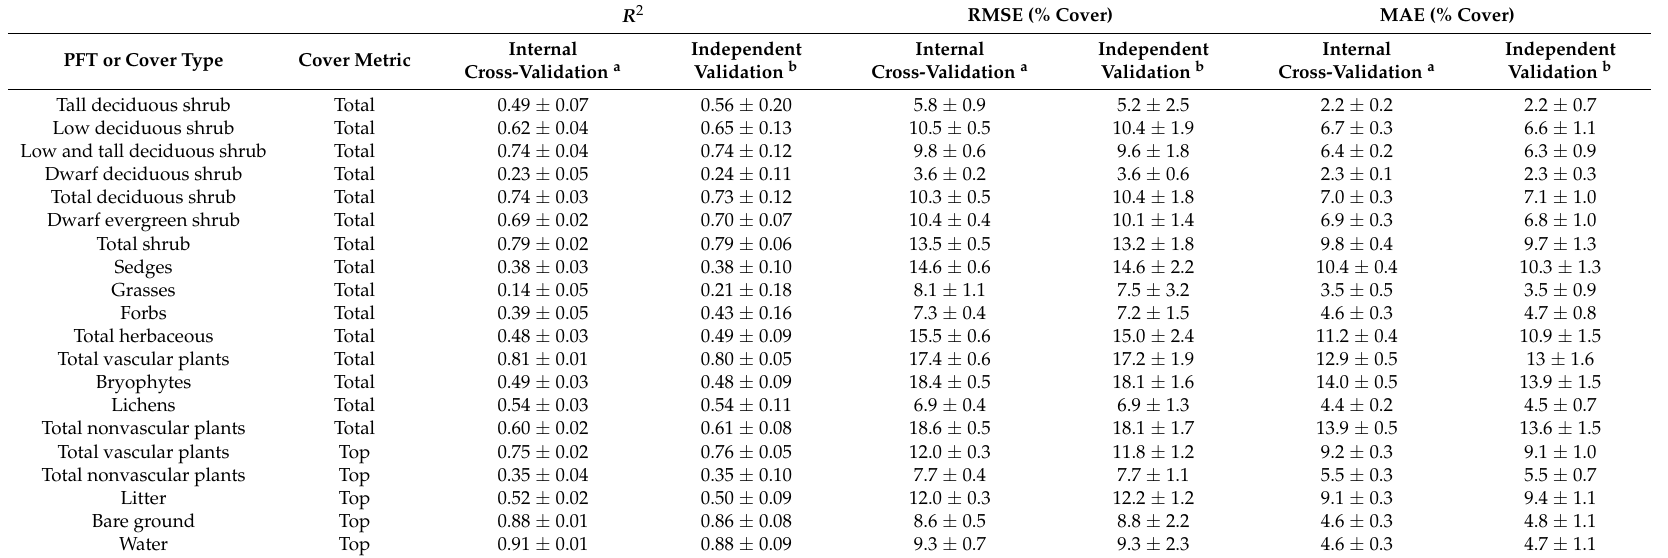
Table 5. Ensemble performance metrics for cover models using full set of 78 predictors, based on cross-validation with training data and independent validation data, North Slope,